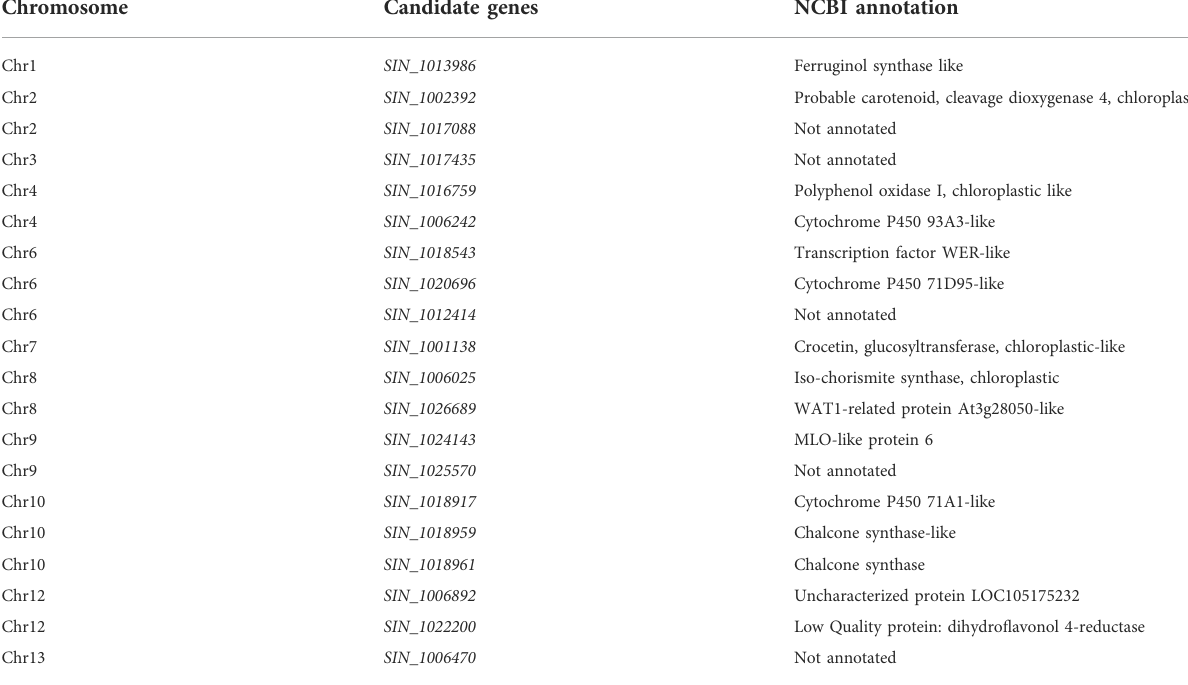
TABLE 6 Twenty candidate genes responsible for seed coat color.